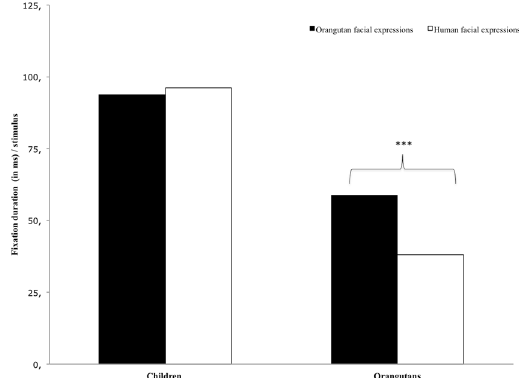
Figure 4. Fixation durations (in ms) per stimulus for children and orangutans on facial expressions of orangutans (black bars) and humans (white bars). Significant comparisons are indicated by asterisks ( > 0.01 * ; > 0.05 ** ; > 0.01 *** ).